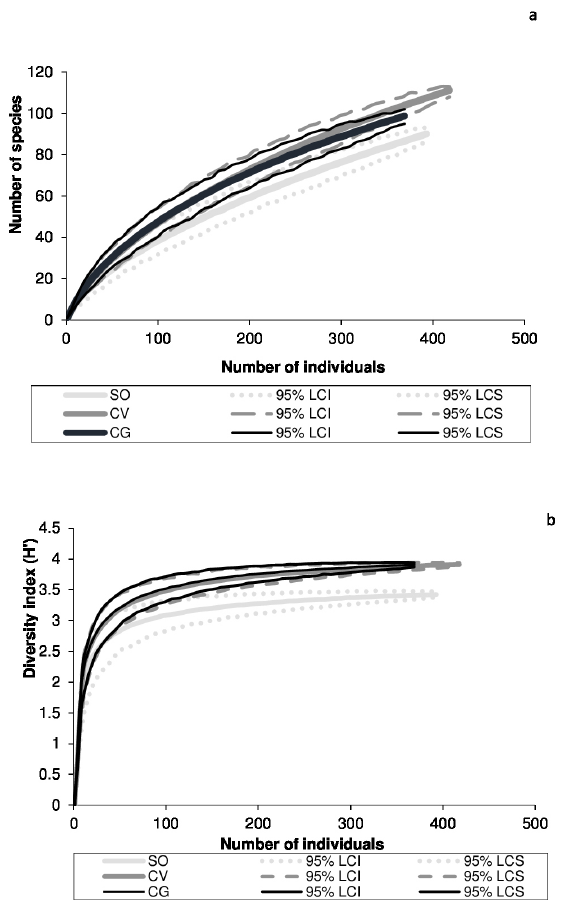
Figure 1 - Species rarefaction curves for richness ( a ) and for diversity H’ ( b ) of tree species sampled in the forest fragments Sooretama (SO, 14 years after fire), Córrego do Veado (CV, 25 years after fire) and Córrego Grande (CG, 25 years after fire), ES, Brazil. Dotted lines are the upper and lower confidence intervals (95%).